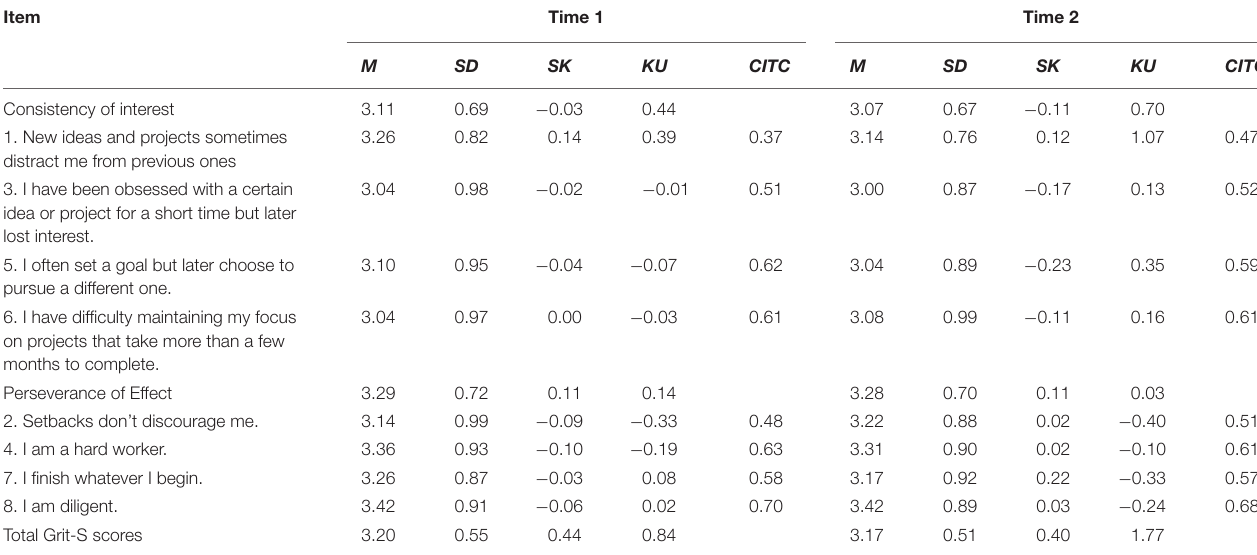
TABLE 2 | Descriptive statistics for the Short Grit Scale at two time points.